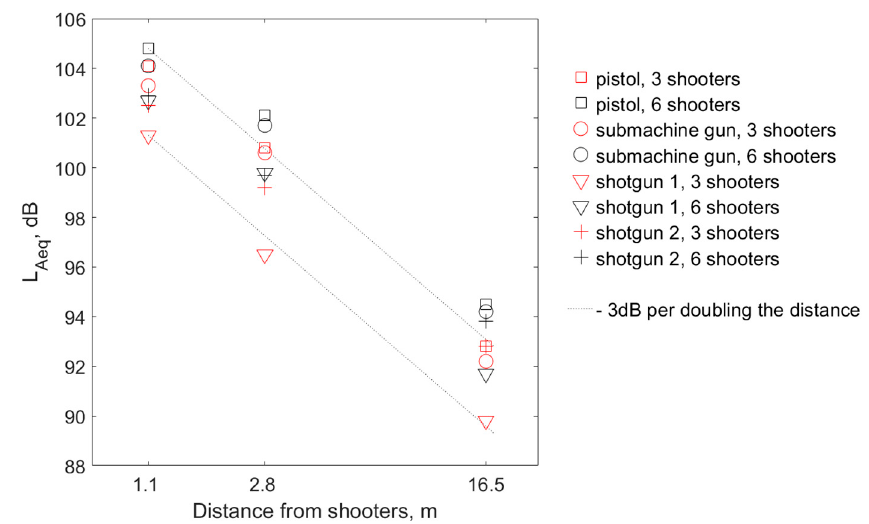
Figure 4. A-weighted equivalent SPL measured at the shooting instructor’s locations, representative of one shooting cycle for both variants of the number of shooters (three or six) simultaneously firing at three different distances between the shooting instructor and the shooters. The values were determined as a result of averaging of all data obtained during the tests at the shooting range under the determined conditions. A logarithmic (base 10) scale is used for the X-axis. Dotted line—a line with a slope of − 3 dB per doubling the distance.